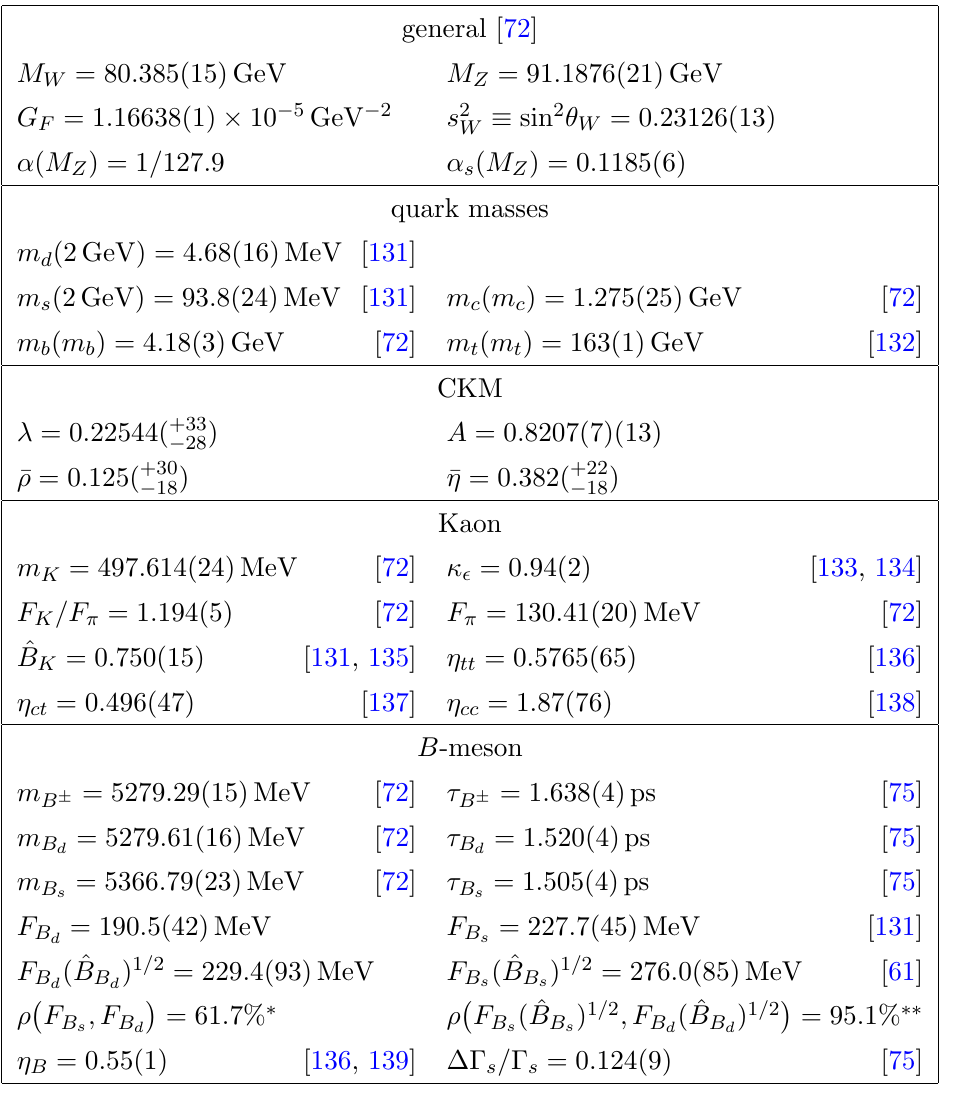
Table 13. Values of the experimental and theoretical quantities used as input parameters as of March 2016. (cid:3) : Calculated by demanding that the uncertainty of the ratio of the decay constants given above should equal the uncertainty given explicitly for the ratio, also given in ref. [131]. (cid:3)(cid:3) : Calculated from information given in ref. [61]. Note that their assumption for the SU(3) breaking from the charm sea contribution corresponds to the assumption of a 91 : 8% correlation for this uncertainty between B d and B s